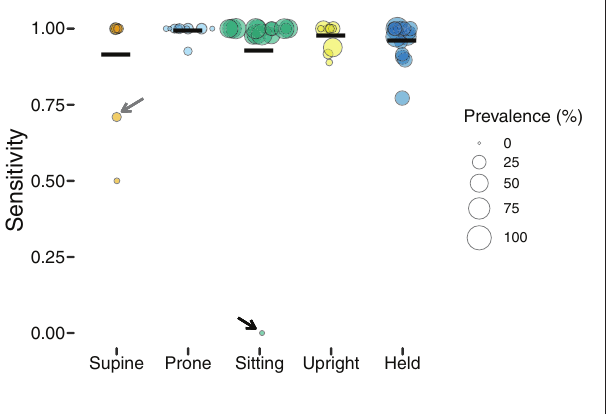
FIGURE 3 | Sensitivity of classification by position in the laboratory study. Each individual circle is the sensitivity for one participant; the size of the point is scaled by the prevalence of that position for that participant (colors indicate body position). Horizontal black lines show the mean sensitivity for each position. Arrows indicate outliers with poor sensitivity that are discussed in text.